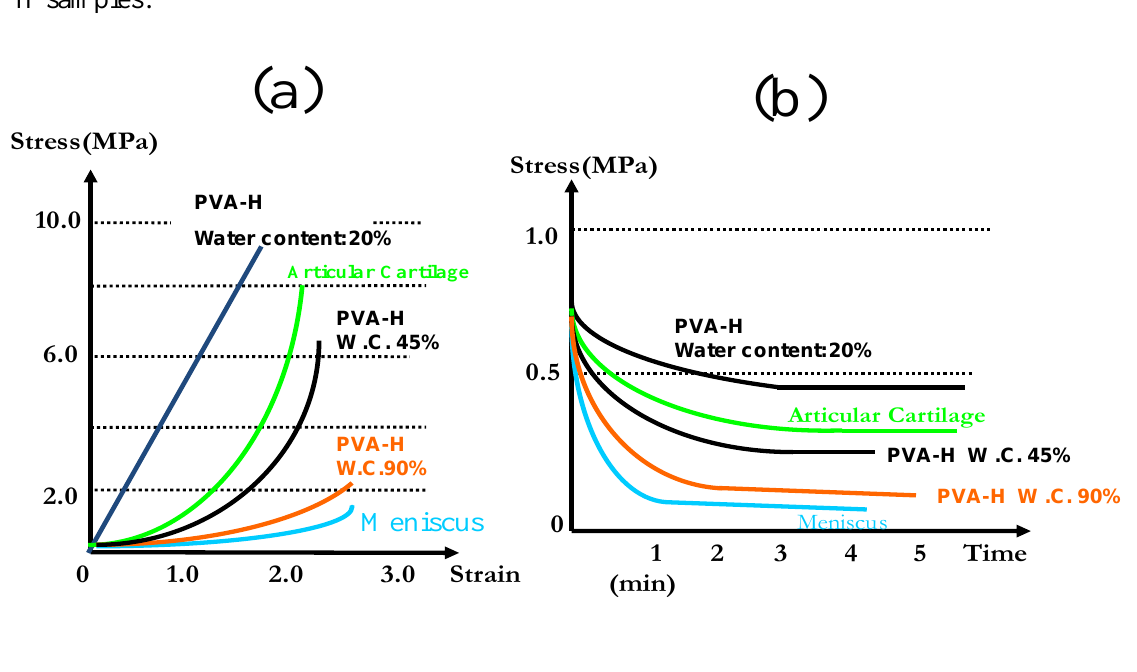
Figure 4. The visco-elastic characteristics of PVA-H. (a) Representative stress-strain curves of various PVA-H samples. (b) Comparison of the stress-relaxation curves of PVA- H